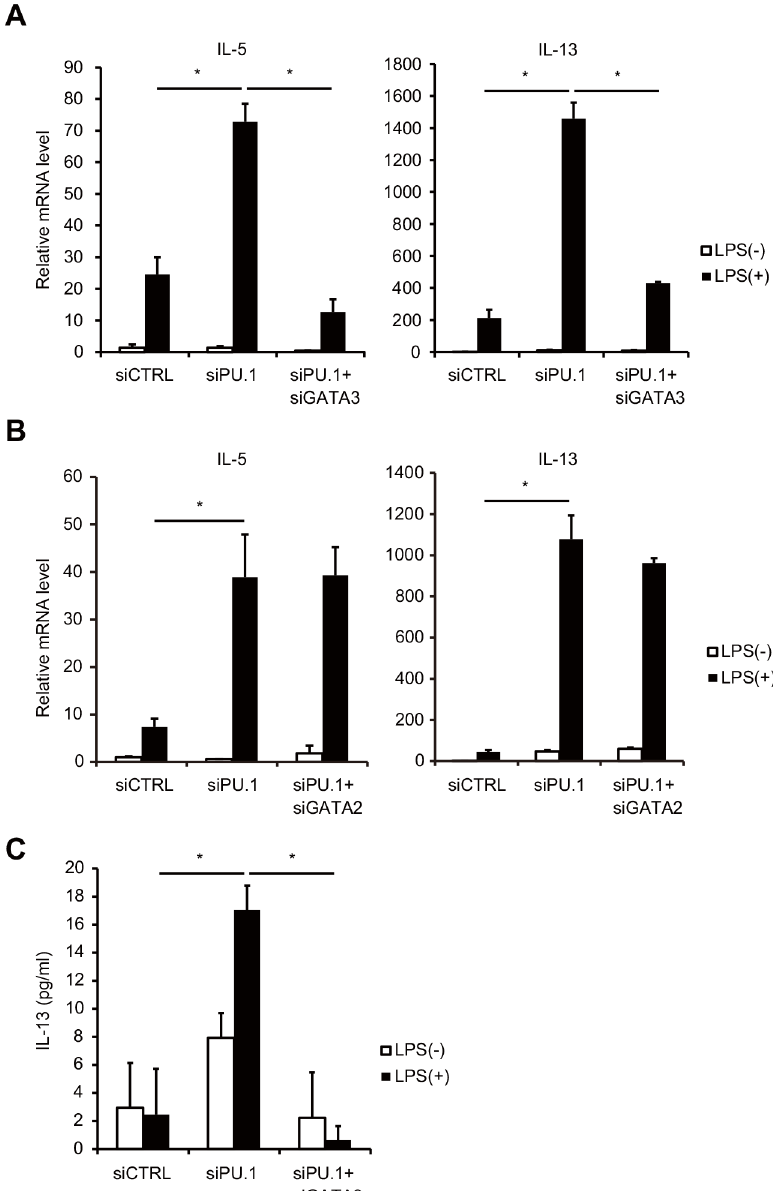
Fig 3. Increased expression of GATA3 is involved in the LPS-inducible IL-13 upregulation in PU.1 knockdown cells. BMDCs were transfected with the indicated siRNAs. After 48 h incubation, the cells were stimulated with (black bars) or without (white bars) of 1 μ g/ml LPS for 6 h. (A, B) Relative mRNA levels of the indicated cytokines were determined by quantitative RT-PCR after normalizing to GAPDH mRNA. Data are expressed as the ratio of the expression level of respective control siRNA-introduced cells without LPS stimulation. (C) IL-13 protein concentrations in the supernatant were measured using ELISA. All results are means ± S.E.s ( n = 3). Similar results were obtained in three separate experiments. * , p < 0.05 in a two-tailed paired Student ’ s t